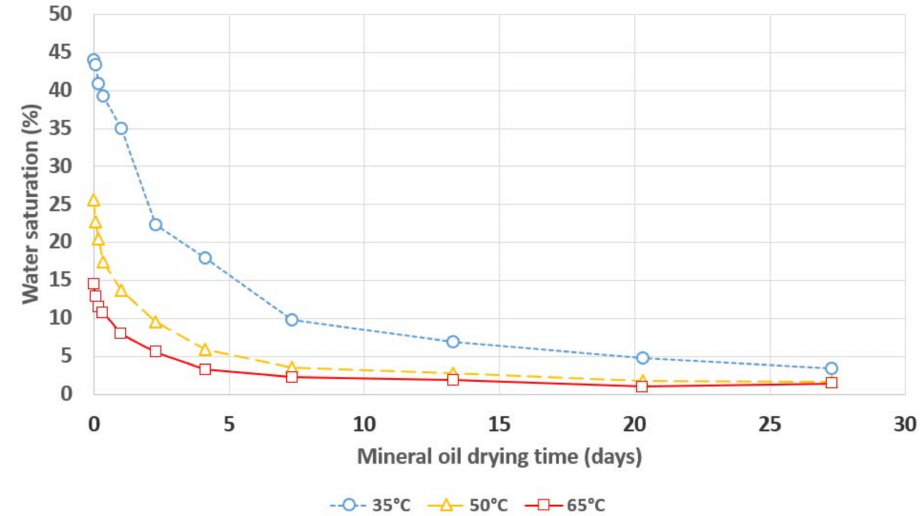
Figure 5. Relative saturation of water in mineral oil during its drying with a 3A molecular sieve.